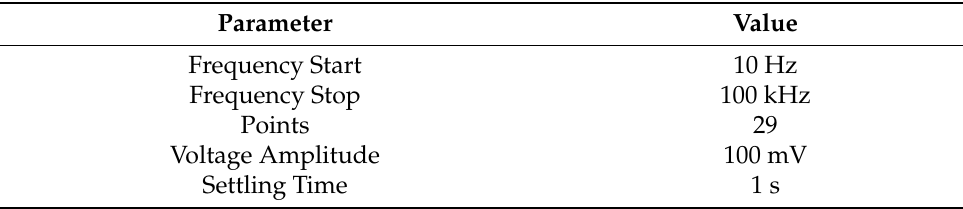
Table 2. Experimental parameters for impedance spectroscopy measurements.